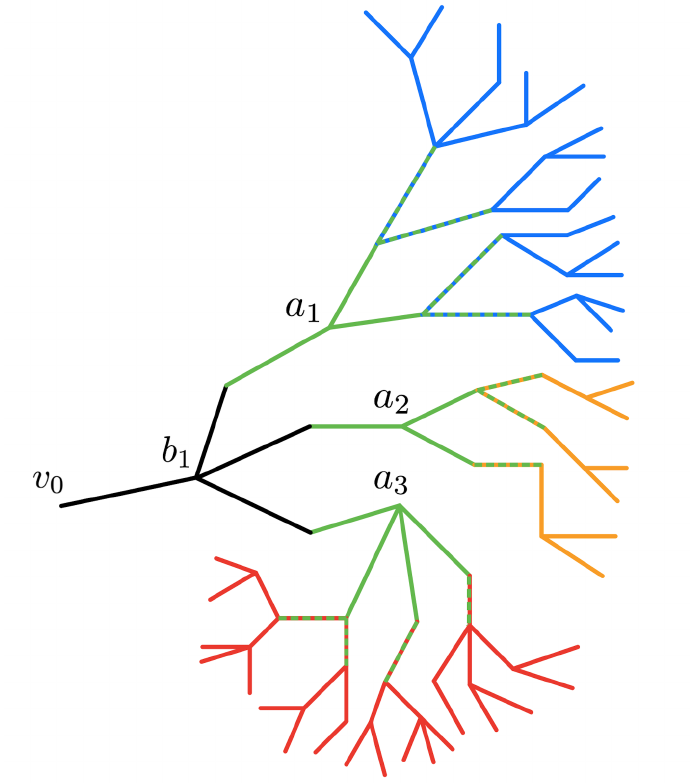
Figure 3. An illustration of jet subsets J ( v ; l 1 , l 2 ) and margins in a